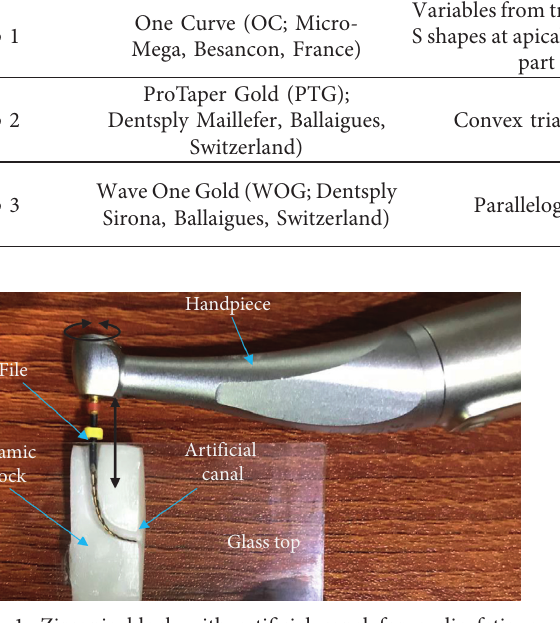
Figure 1: Zirconia block with artificial canal for cyclic fatigue testing of endodontic